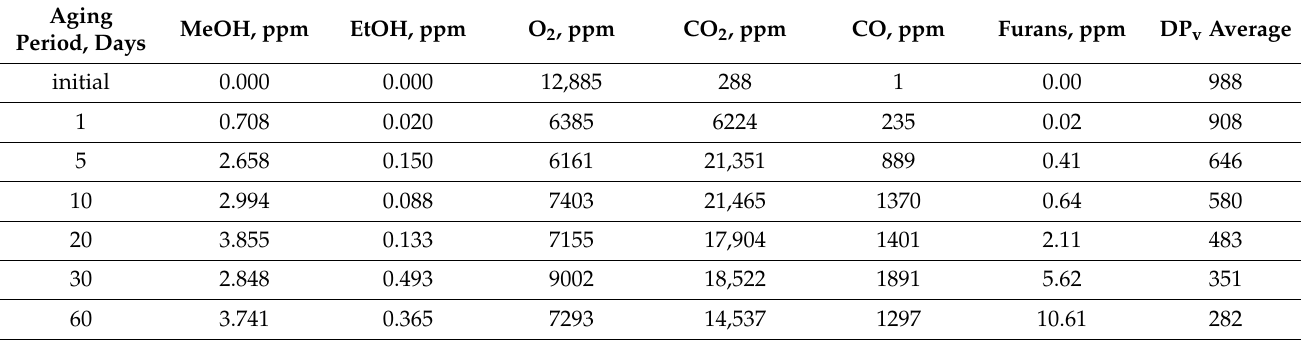
Table 5. Change of aging markers concentrations during experiment II (oil and paper) at 120 ◦ C.